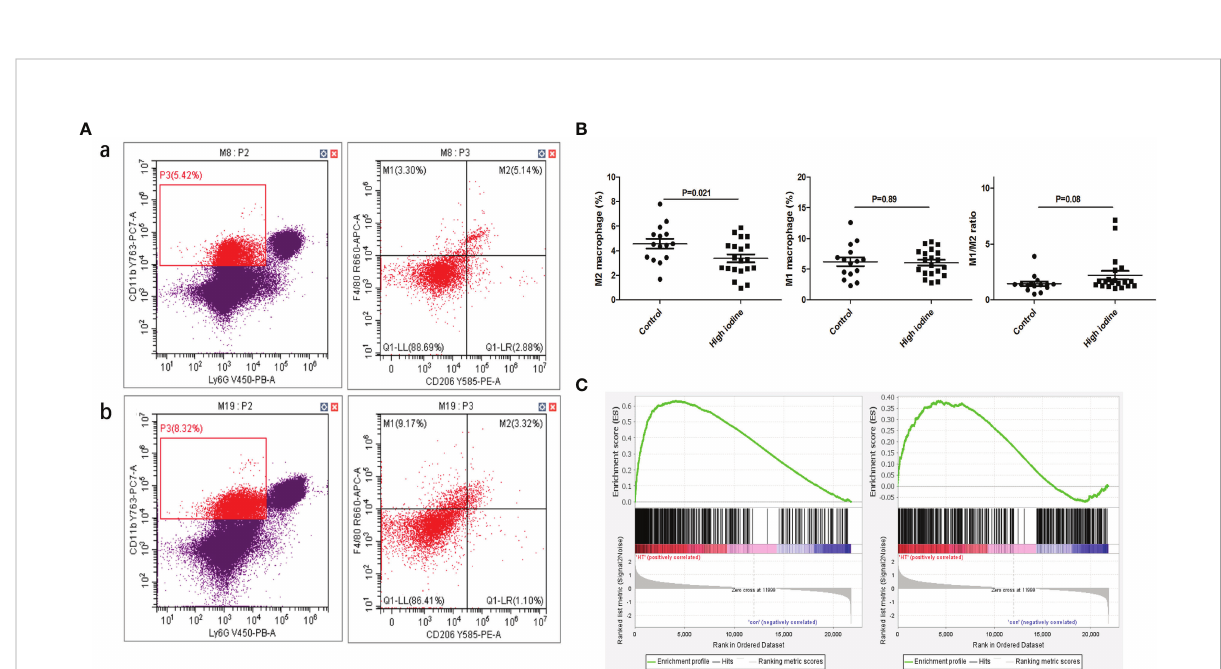
FIGURE 5 Effect of high iodine on mouse macrophage polarization. (A) Flow cytometry of macrophage proportions in spleen tissue. a: control group; b: model group; (B) Statistics of macrophage proportions; (C) GSEA of macrophage polarization in transcriptome of thyroid tissue from model group (From left to right: M1 and